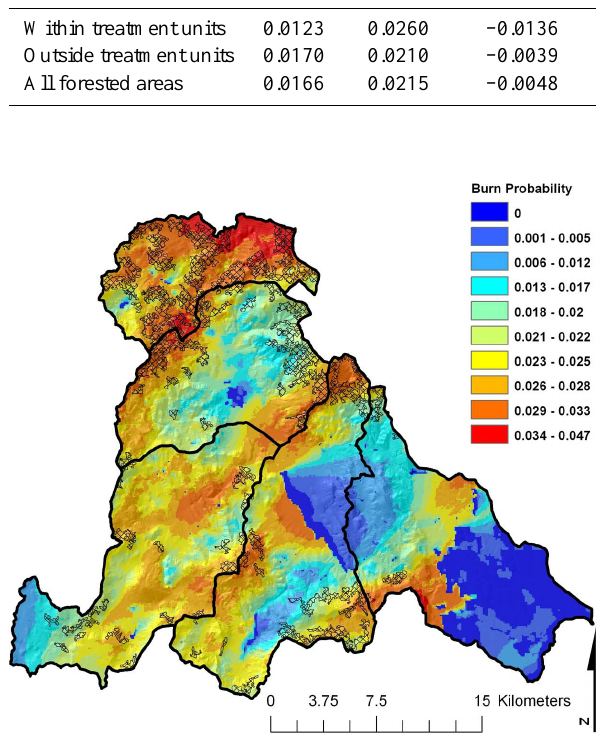
Fig. 2. Burn probability map generated from simulating 30000wildfires with randomly located ignitions. Burn probability is the chance a pixel burns given a random ignition and resulting wildfire under the conditions used in the simulation.